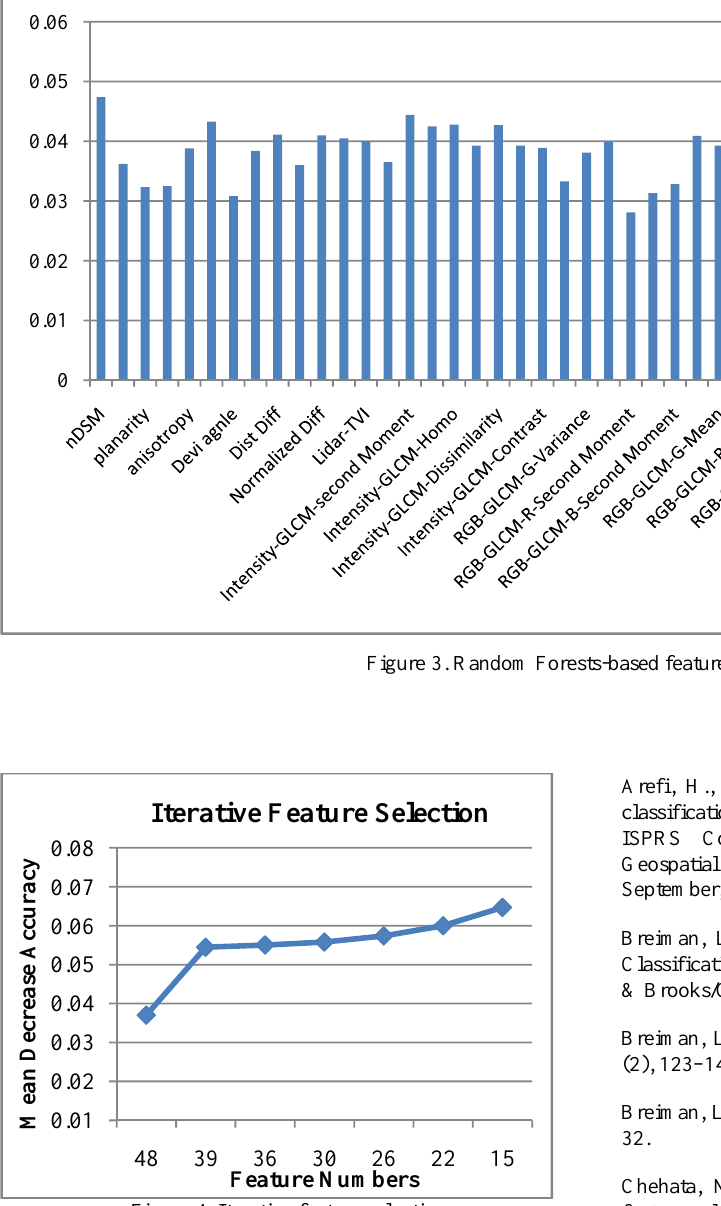
Figure 4. Iterative feature